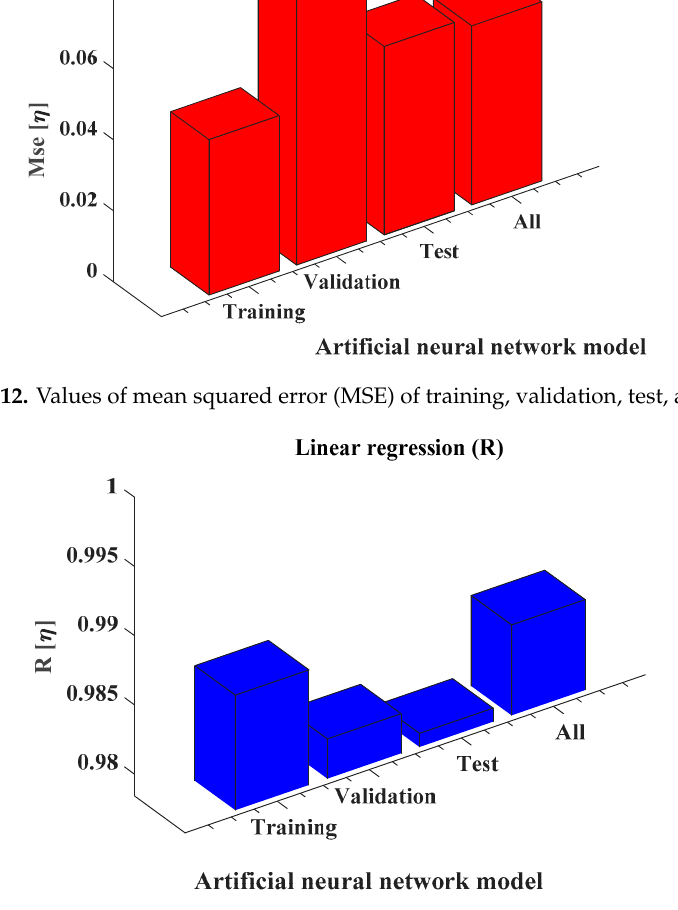
Figure 13. The correlation coefficient of training, validation, test, and all for artificial neural network (ANN).